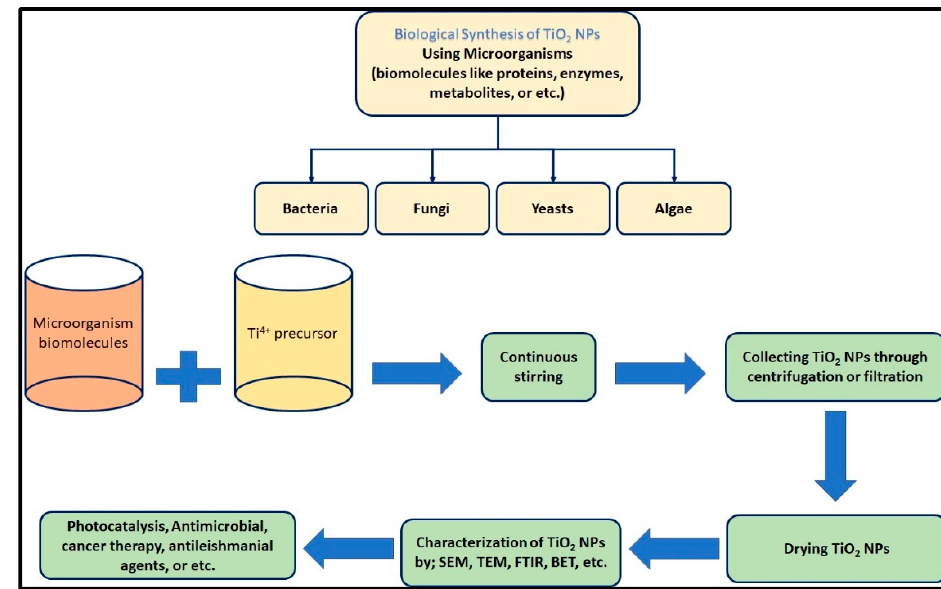
Figure 5. Green synthesis of TiO 2